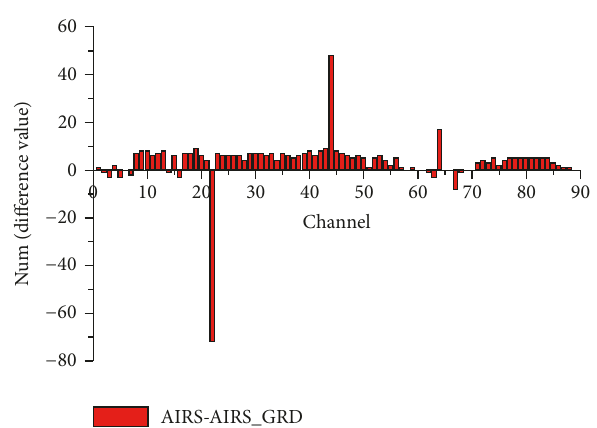
Figure 9: The difference of FOV’s numbers from 88 channels between the AIRS test and the AIRS_GRD